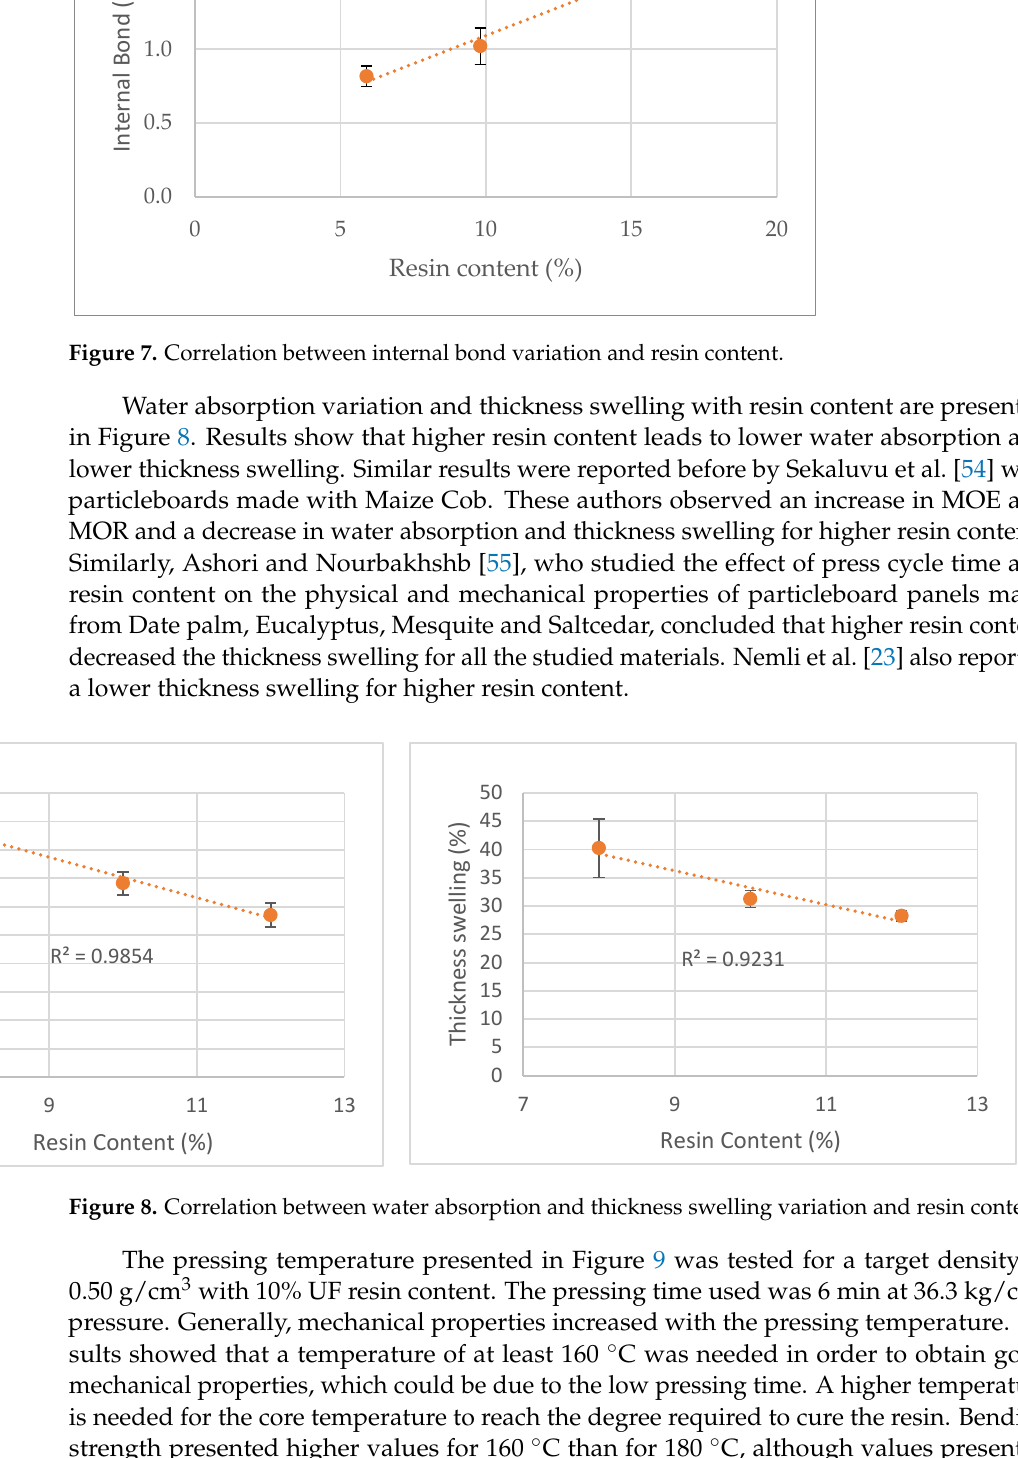
9 of 16 Figure 6. Correlation between bending strength and MOE variation and resin content. Internal bond (Figure 7) increases with the increase in resin content from around 0.7 MPa for 6% resin content to more than 1.5 MPa for 17% resin content. Similarly, Nemli et al. [23] reported that internal bond increased from 0.483 to 0.648 MPa for commercially